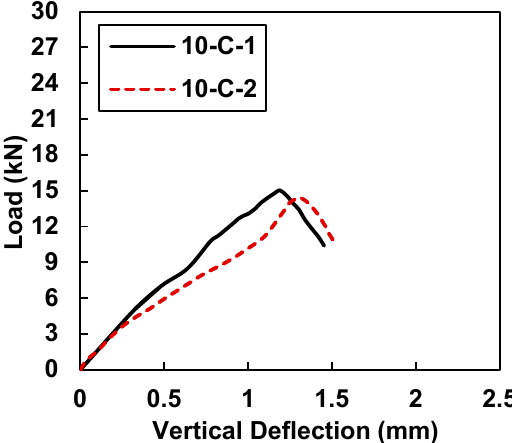
Figure 5. Load vs. midspan deflection for control samples (C-1 and C-2). The specimen C-1 depicted peak load values lower than the C-2 specimen, which was mainly attributed to the heterogenous behavior of concrete and the sensitivity of un-reinforced concrete samples to tensile stresses. However, for comparison purposes, the average value of both specimens (C-1 and C-2) was used. Figure 6 shows the load- displacement behavior of 10-C-1 and 10-C-2, which were retrofitted with 10 mm CFRP strips. In comparison to the control samples, 10-C-1 and 10-C-2 showed improved behavior in terms of load-carrying capacity and deflection. Table 5 shows the peak load and midspan deflection values of 15.03 kN and 1.188 mm for sample 10-C-1, whereas sample 10-C-2 had maximum load and midspan deflection values of 14.43 kN and 1.308 mm, respectively. In comparison to the control samples (C-1 and C-2), on average an increase of 74.32% was observed in terms of the load-carrying capacity. Further, the deformation capacity was improved by 36.81% on average. A slight variation in the initial stiffness of sample 10-C-1 was observed. This variation might have been due to the uneven surface of sample 10-C-1 at the supports. Once the sample had settled itself on the support, it showed behavior similar to 10-C-2.